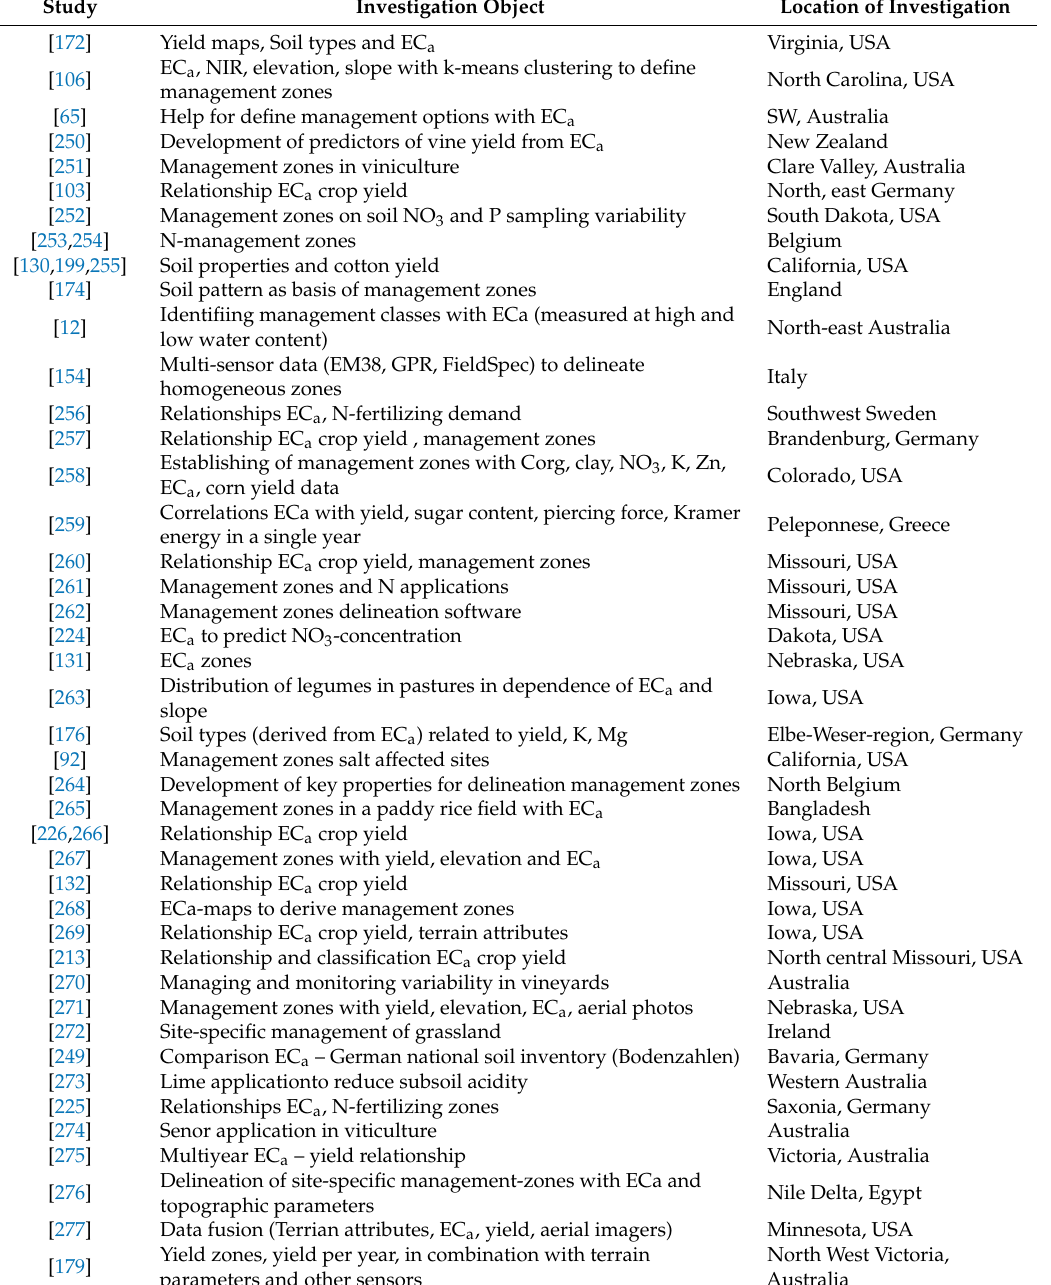
Table 6. Composition of literature with derivations of yield maps, management zones and selection of areas for fertilization with EM38-EC a